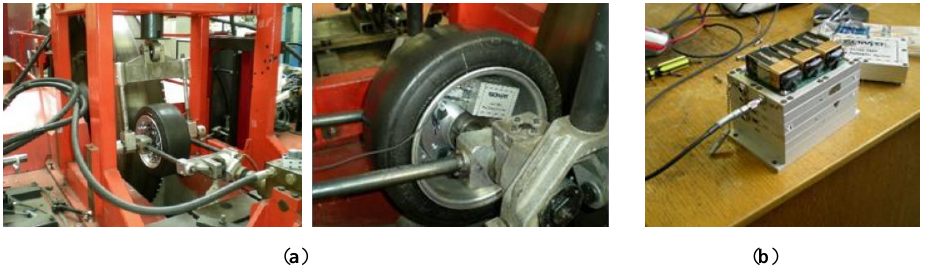
Figure 1. ( a ) Indoor tire test rig; ( b ) Acquisition system SoMat2000® .